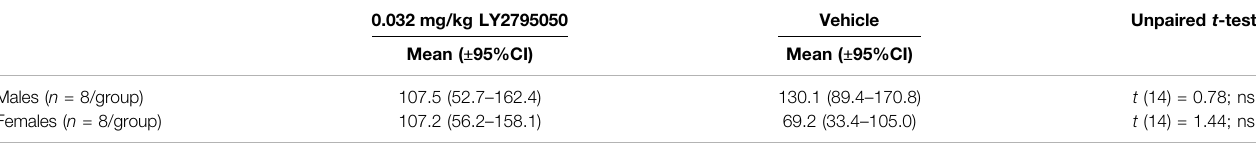
TABLE 1 | Immobility in the last 5-min bin (i.e., 11 – 15 min) of the open space swim session after a 10-fold smaller dose of LY27950590 (0.032